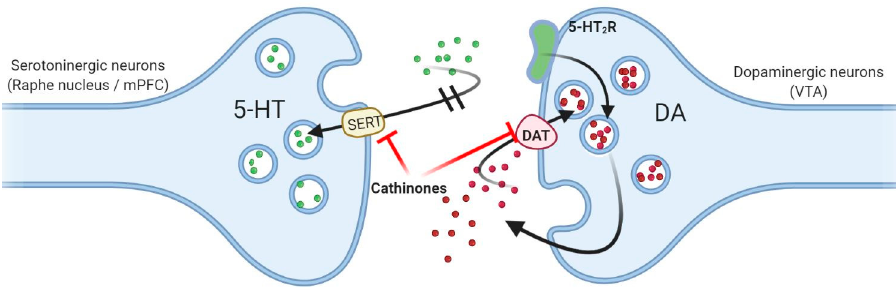
Figure 3. The general mechanisms proposed for promoting dopaminergic neurotransmission by cathinones. Cathinones inhibit the reuptake of serotonin (5-HT) and dopamine (DA) from the synaptic cleft by blocking the activity of transporters for 5-HT (SERT) and DA (DAT), and subsequently leading to accumulation of 5-HT which stimulates postsynaptic 5-HT 2A receptors (5-HT 2 R) favoring the release of DA in the synaptic cleft (and which then remains at this level and cannot be recaptured). Created with BioRender.com (accessed on 22 January